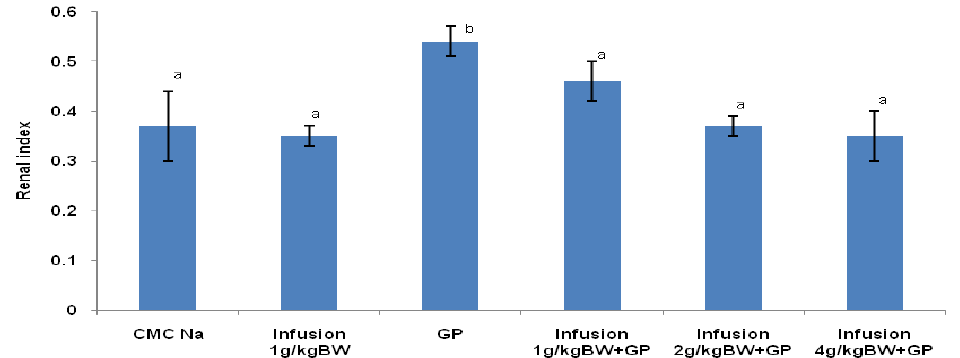
Figure 3. The effect of sarang semut infusion on renal index profile (Mean ±SD) (n=4)